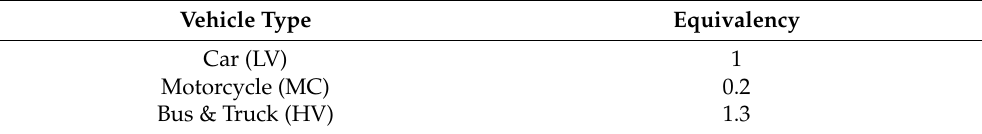
Table 1. Vehicle type equivalency